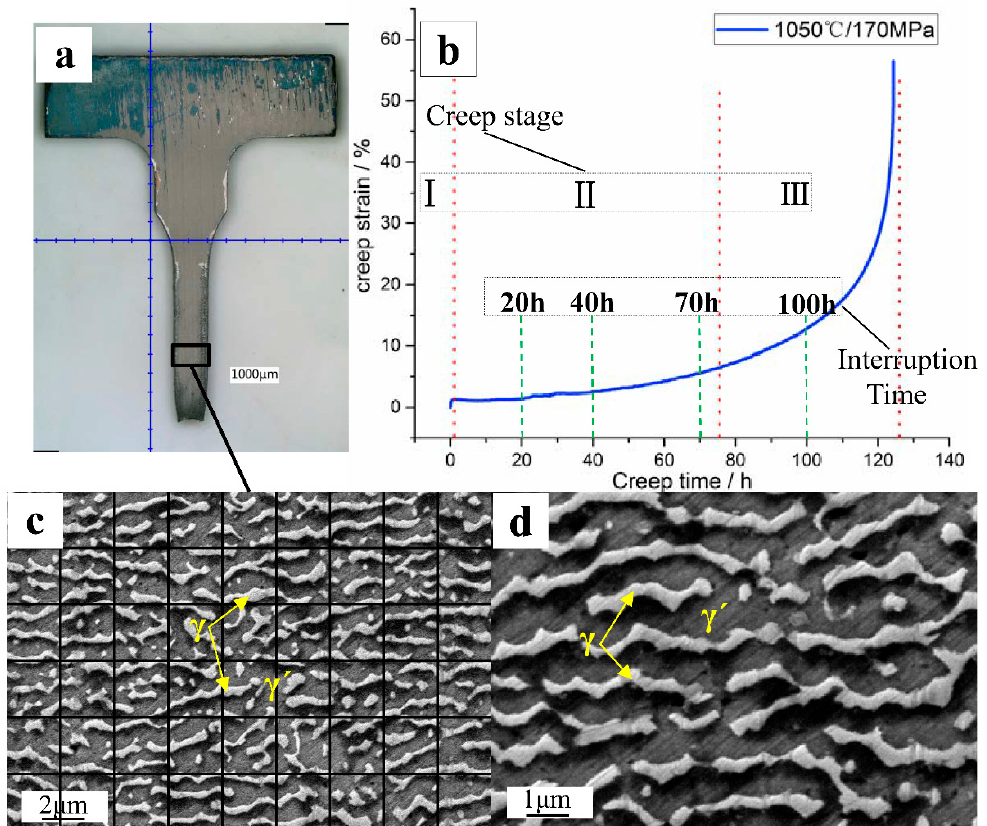
Table 2. Creep strain and strain rate of samples under different creep interruption time.